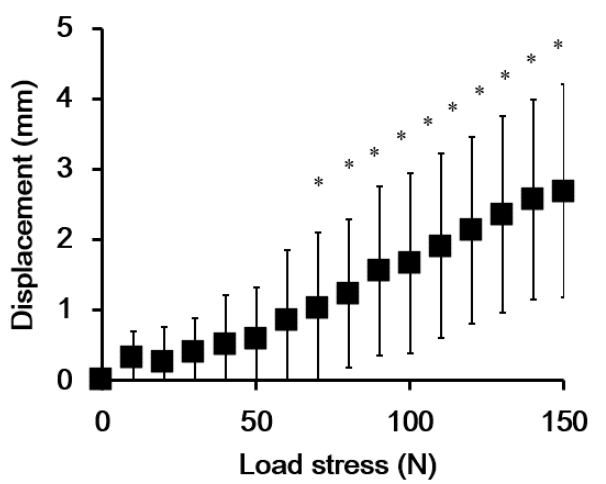
Figure 6. The average amount of anterior talar displacement measured from ultrasound images of participants in the control group (8 subjects, 16 ankles). Error bars represent standard deviation values. * Indicates a significant difference compared to the 0 N baseline condition ( p < 0.05).